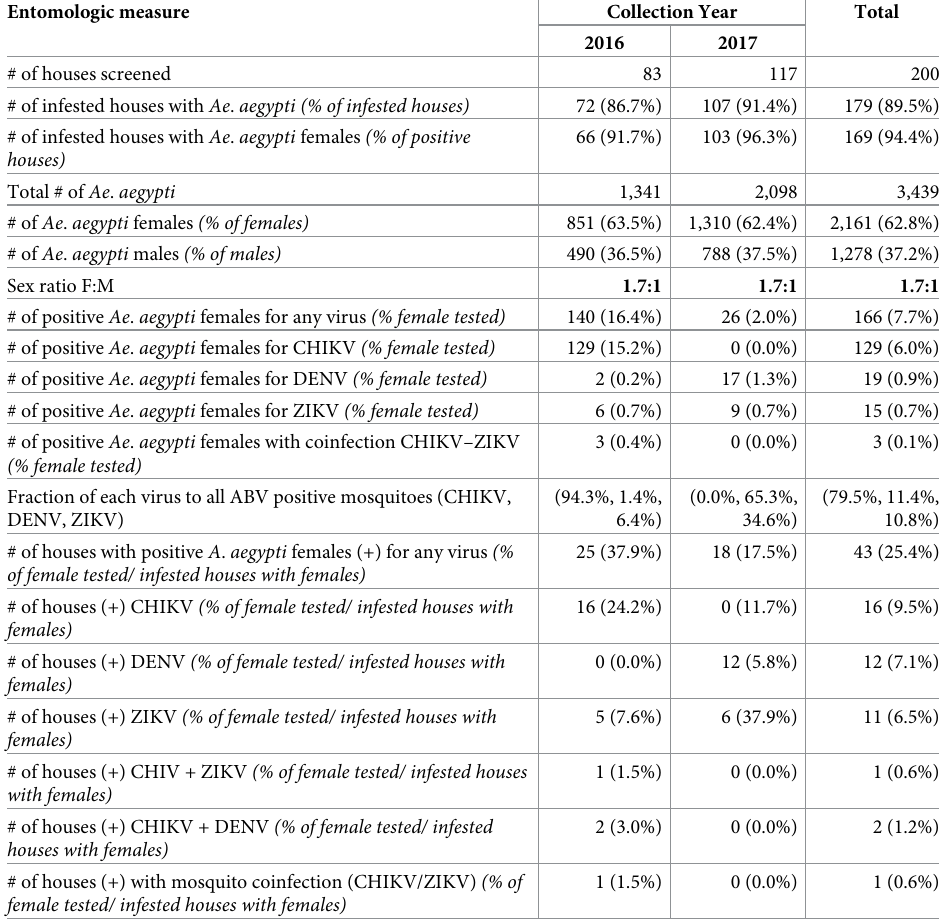
Table 1. Descriptive measures and Infection rates in indoor resting Ae . aegypti mosquitoes from Yucata´n, Mexico, collected during the ABV transmission seasons of 2016 and 2017. Entomologic